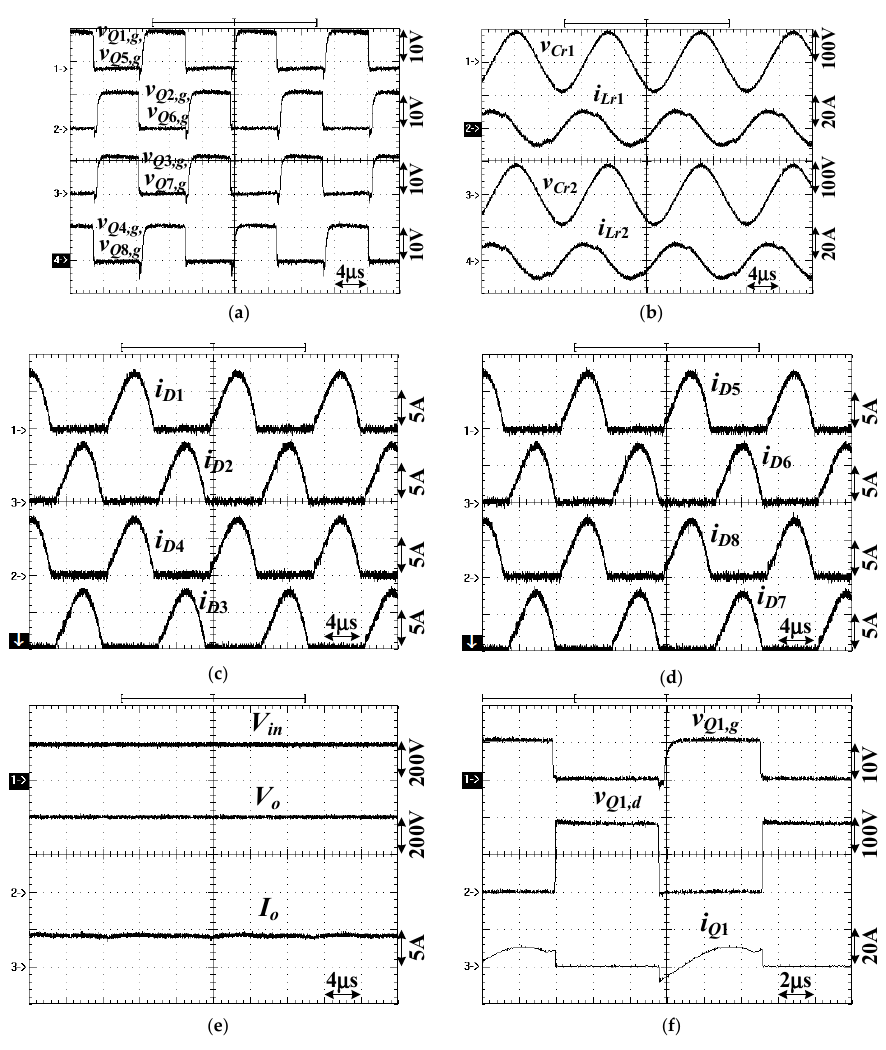
Figure 9. Experimental results at V in = 190 V (low voltage range) and 1.8 kW load. (a) v Q 1, g ~ v Q 8, g, (b) v Cr1 , i Lr 1 , v Cr 2 , i Lr 2, (c) i D 1 ~ i D 4, (d) i D 5 ~ i D 8, (e) V in , V o , I o, (f) v Q 1 ,g , v Q 1 ,d , i Q 1 .